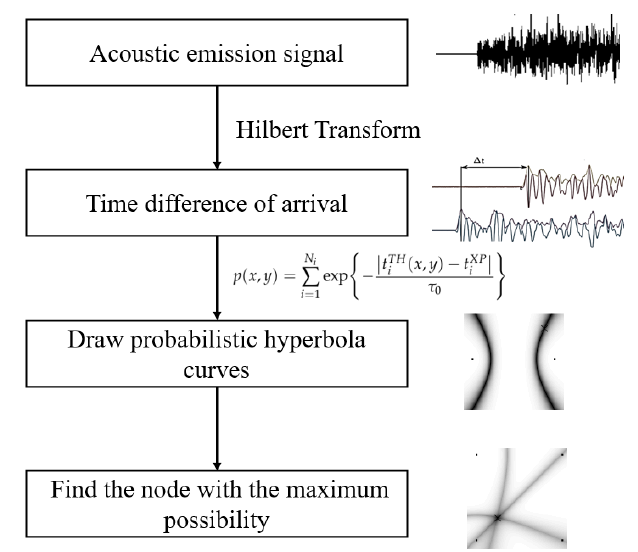
Figure 1. The overall diagram of the proposed impact location framework.